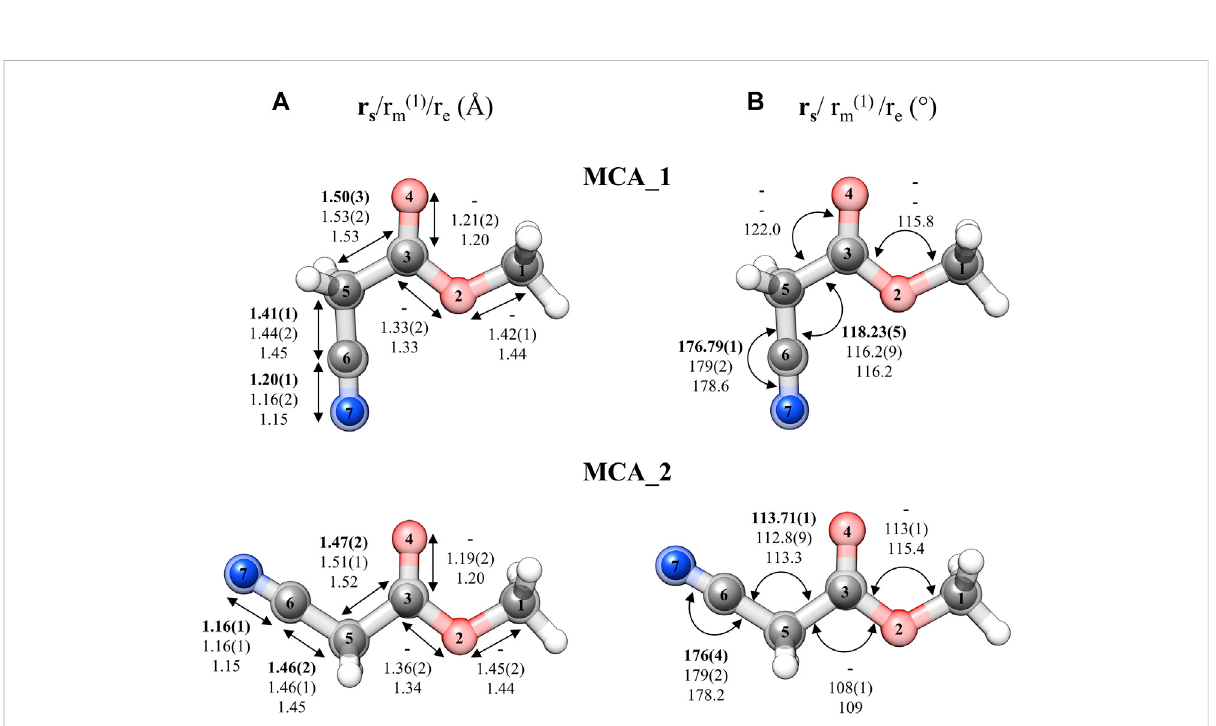
FIGURE 6 The experimental structures of MCA_1 and MCA_2. The inner bold spheres represent the r s positions of the atoms, whereas the partially transparent backbone gives the theoretical r e structures (B3LYP-D3/aug-cc-pVTZ level of theory). The bond distances (panel (A) ) and angles (panel (B) ) obtained by the three methods, r s , r m (1) , and r e , are also included where